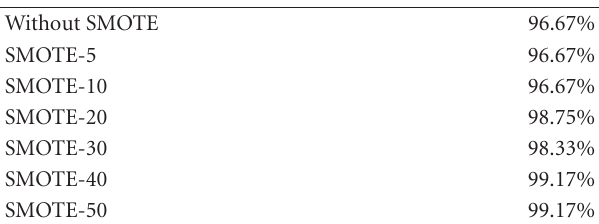
Table 3: The recognition rate by